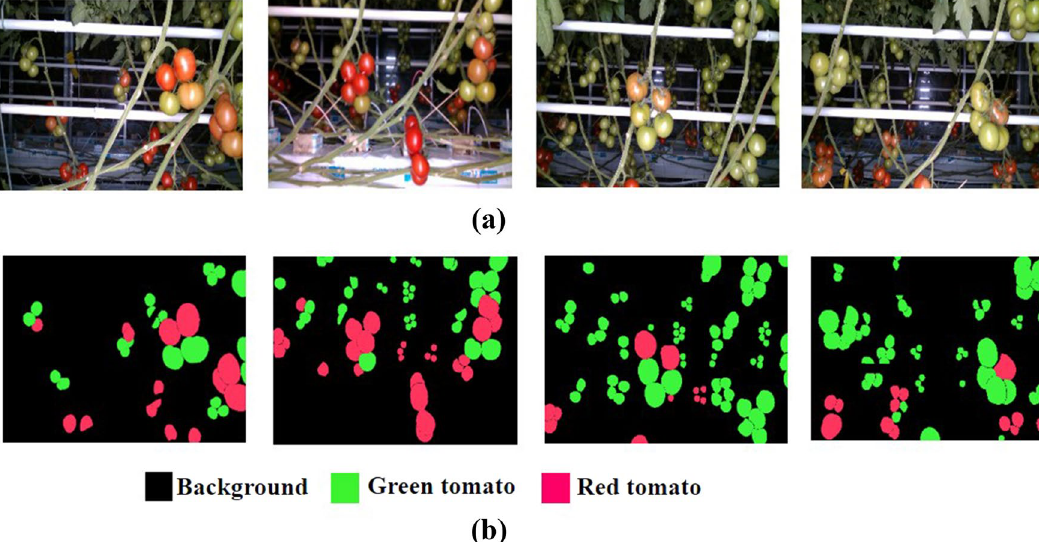
Figure 1. Image data before and after pre-processing ( a ) sample original images from the tomato dataset (Afonso et al. 18 ), ( b ) sample ground-truth